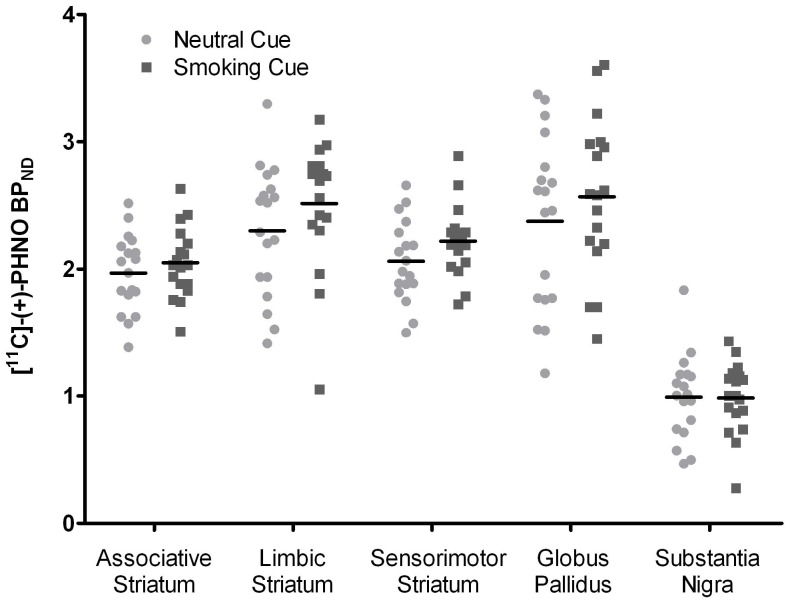
[11C]-(+)-PHNO BPND in brain regions of interest.[11C]-(+)-PHNO BPND in the associative striatum (AST), limbic striatum (LST), sensorimotor striatum (SMST), globus pallidus (GP) and substantia nigra (SN) in the neutral and smoking cue conditions. There were no overall significant differences between the cue conditions in [11C]-(+)-PHNO BPND in any of the apriori selected regions of interest.